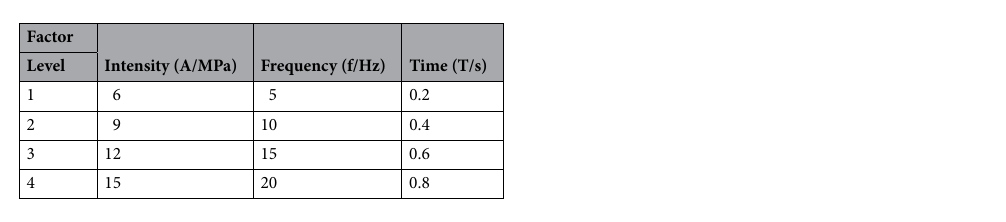
Table 3. Factors and levels.